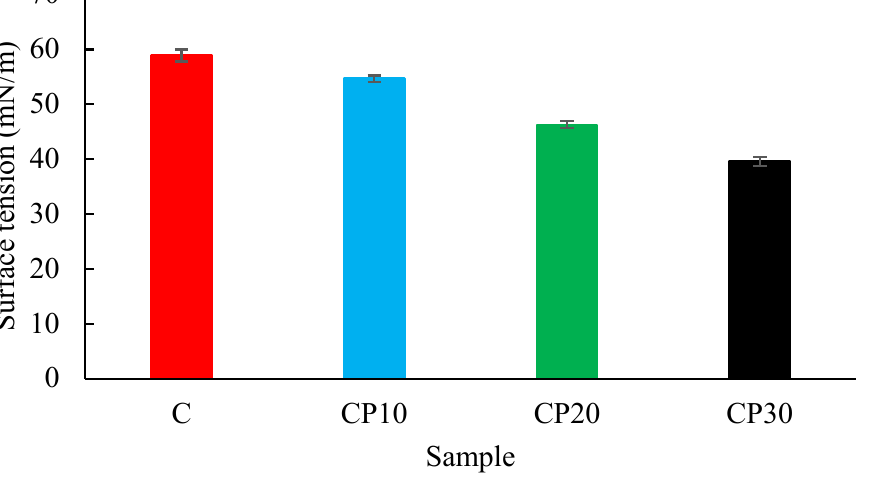
Figure 8. Changes in the Surface tension of different BSG dispersions (0.3%) at 20 °C; C, CP 10 , CP 20 , and CP 30 indicate unmodified samples and those treated by CP for 10, 20, and 30 min, respectively.